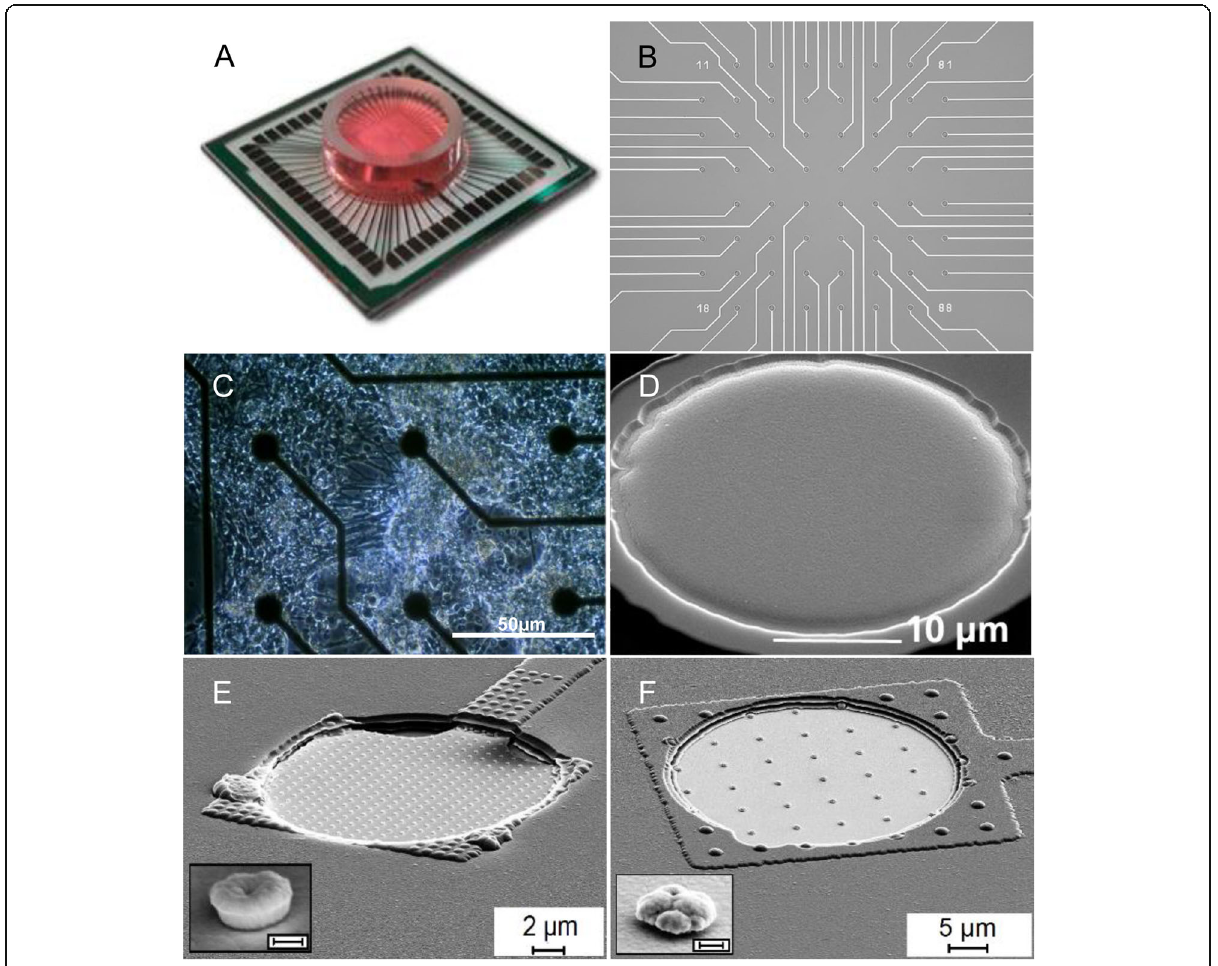
Fig. 1 Exemplary pictures of MEA chips and electrodes of different shapes. A multielectrode array from Multichannel Systems© with 60 electrodes and chamber containing cell culture medium. B Arrangement of electrodes in an array of 60. C Clusters of myenteric neurons growing on planar microelectrodes, scale bar 50 μ m. D SEM picture of a planar electrode, scale bar 10 μ m. E and F SEM pictures of nanostructured MEA electrodes with tube- and mushroom-like nanostructures, scale bars 2 and 5 μ m, respectively (insets: magnification of nanostructures, scale bar: 200 nm; taken with permission from Decker et al.,